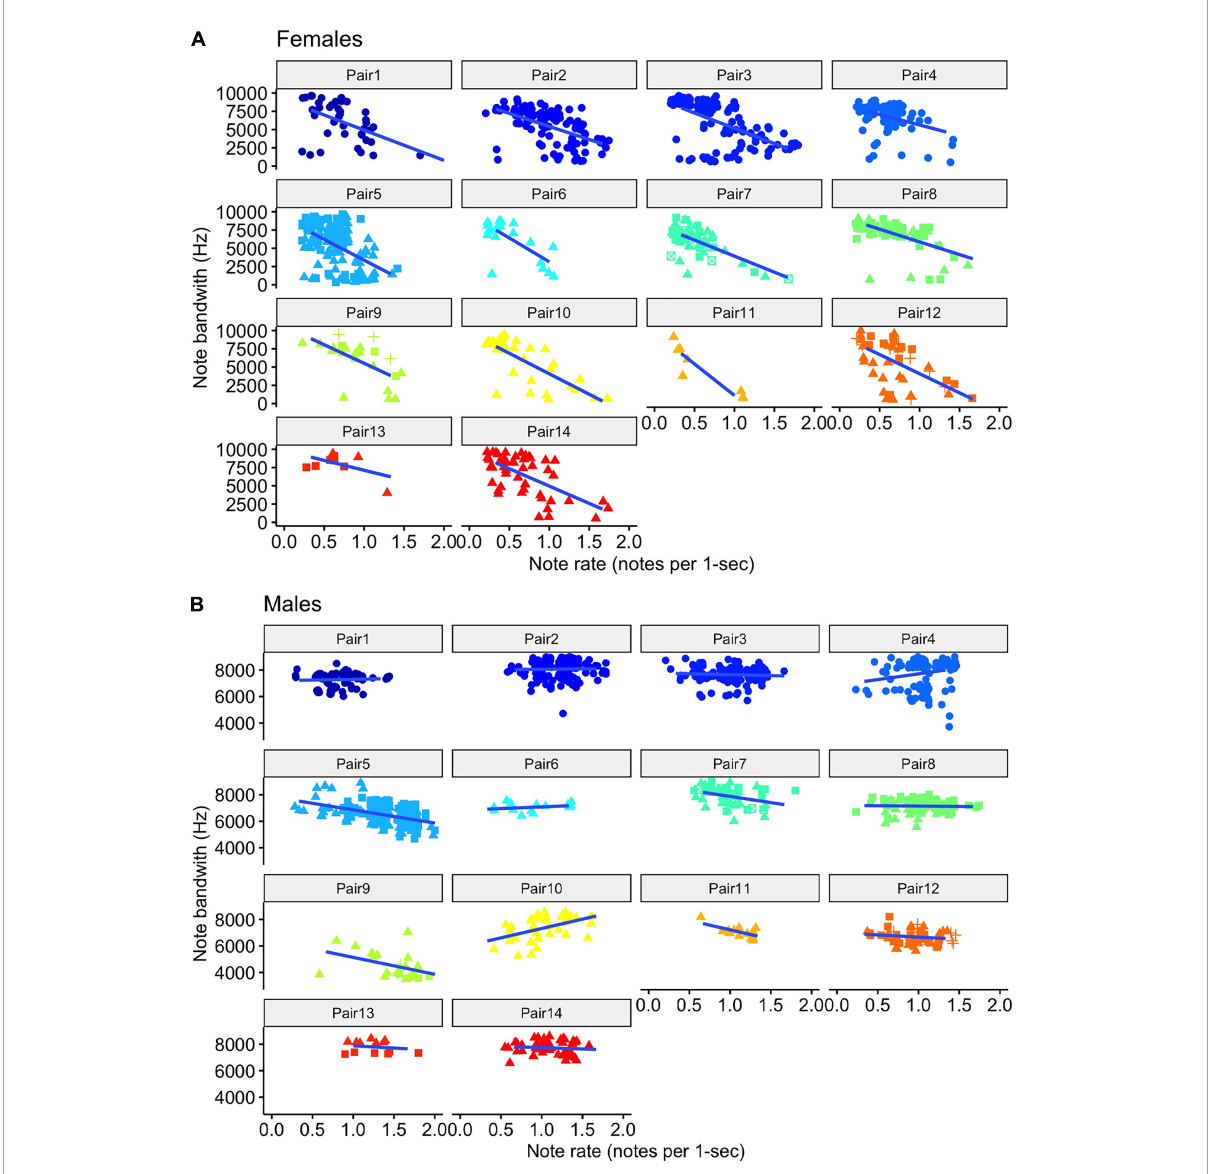
FIGURE6 Scatter plots of note bandwidth as a function of the rate of note output (number of notes per 1-s) for female (A) and male (B) tarsier duets. Note that the female (A) scatterplots use a broader bandwidth scale than the male (B) scatterplots, reflecting the generally wider note bandwidth exhibited by the females. The female scatterplots also show much stronger negative slopes than the male scatterplots. The shape of the points indicates which duet the notes came from. Trend lines were added using the “geom_smooth” function in “ggplot2” to visualize differences across pairs (Wickham,